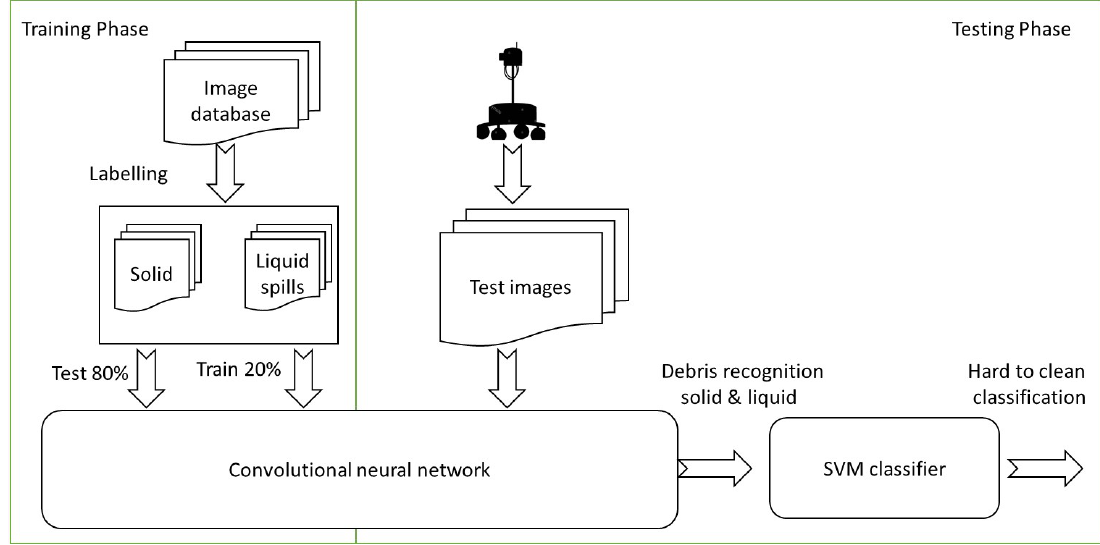
Figure 2. Proposed Scheme: Cascaded CNN and SVM